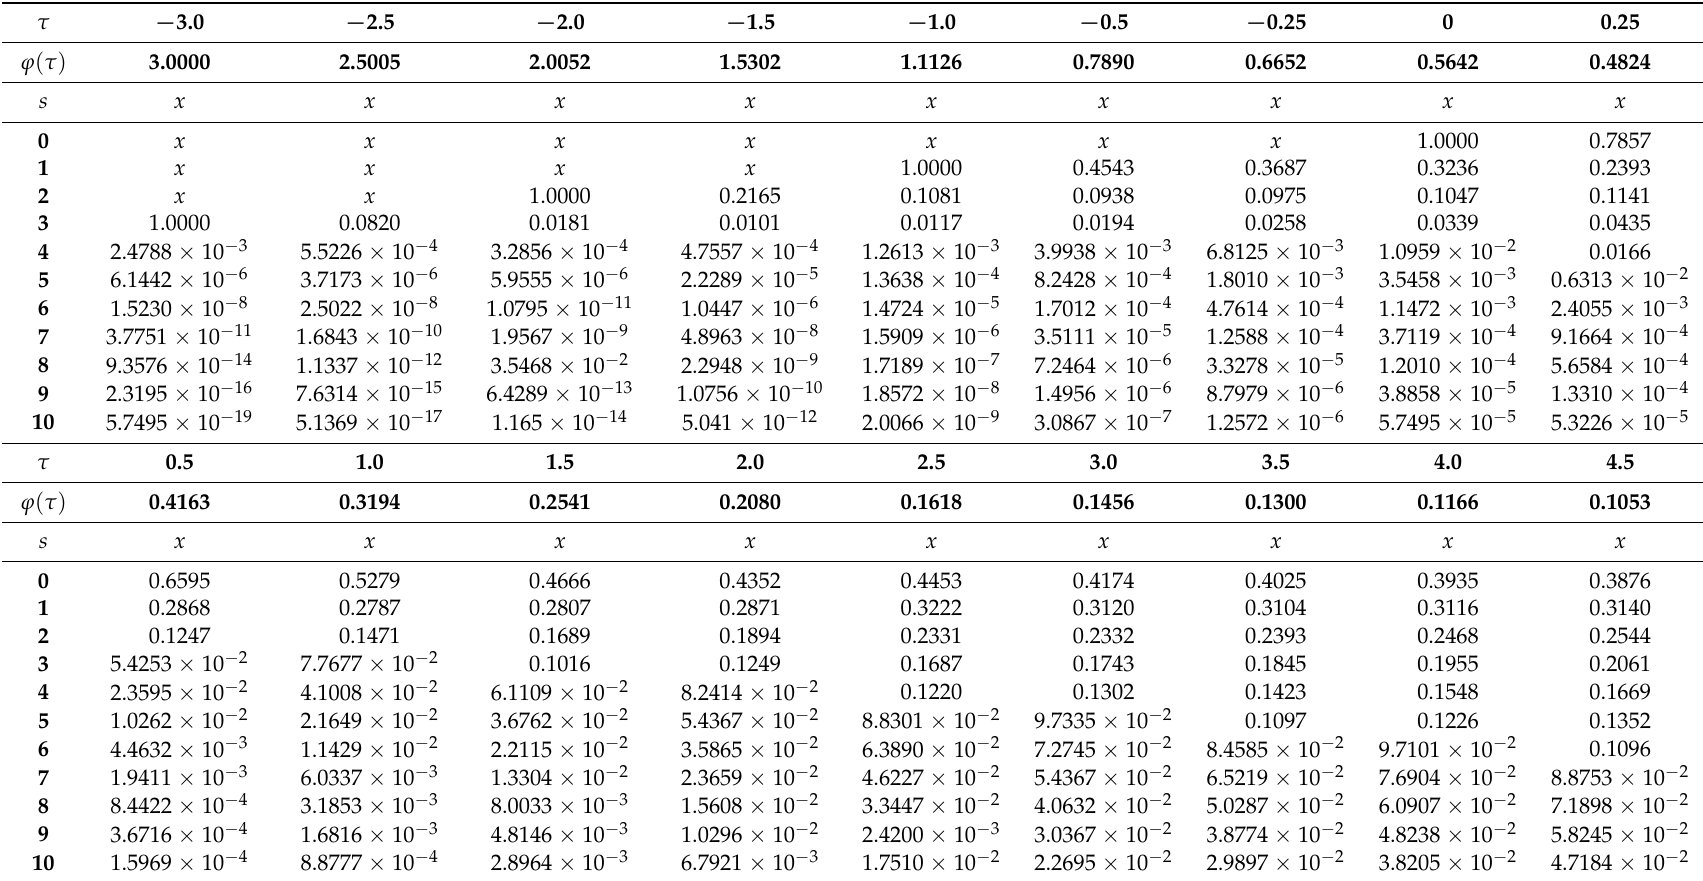
Table 3. Calculated probabilities P = P ( τ , s ) of non-failure as functions of the time τ and factor s